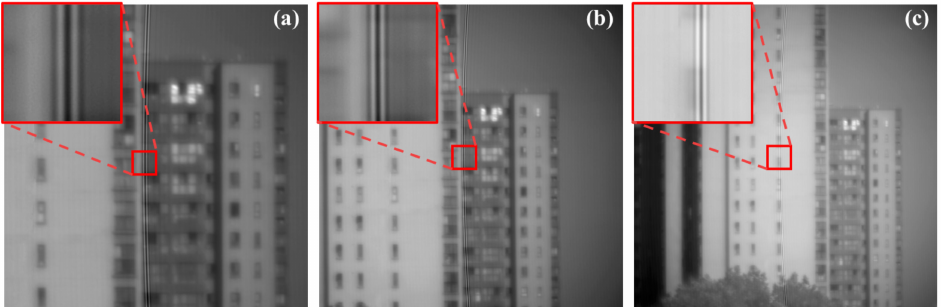
Figure 16. Captured interferograms ( a ) FOV = 5 ◦ , ( b ) FOV = 7.5 ◦ , ( c ) FOV = 10 ◦ .